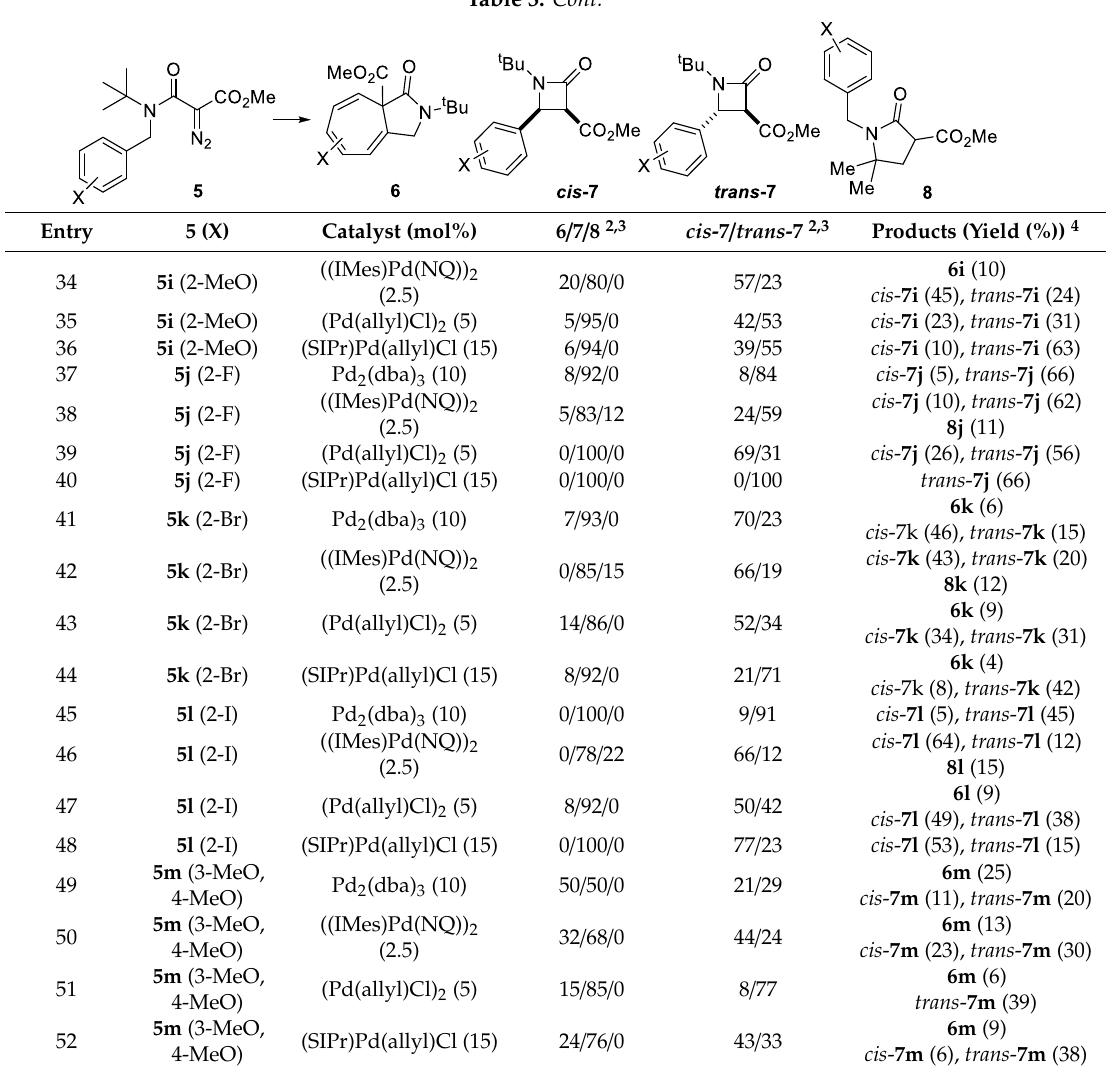
1 Reaction conditions: Catalyst (see table) in DCE at reflux for 24 h. 2 Ratios determined by integration of characteristic 1 H-NMR absorptions from the spectrum of the reaction mixture. 3 The majority of reactions were performed twice, while the Buchner: β -lactam: γ -lactam ratio ( 6 / 7 / 8 ) was essentially the same in the two runs and the cis : trans ratio was quite di ff erent due to the partial isomerization of cis β -lactams to the more stable trans isomers during the work-up or even when recording the 1 H-NMR spectra. 4 Yields refer to products isolated by chromatography. 5 4-(Dimethylamino)benzaldehyde ( 10 ). 6 Mixture of